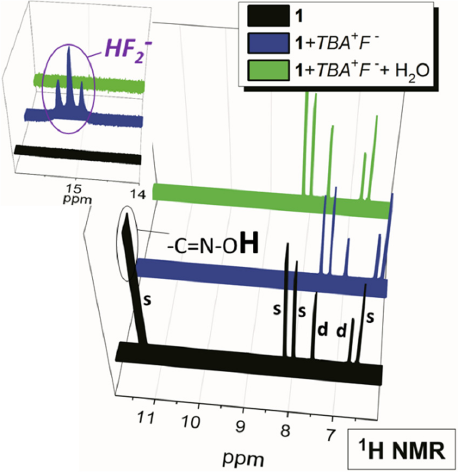
Figure 3. 1 H NMR spectrum of 7-dimethylaminocoumarin oxime 1 in DMSO- d 6 before and after F −